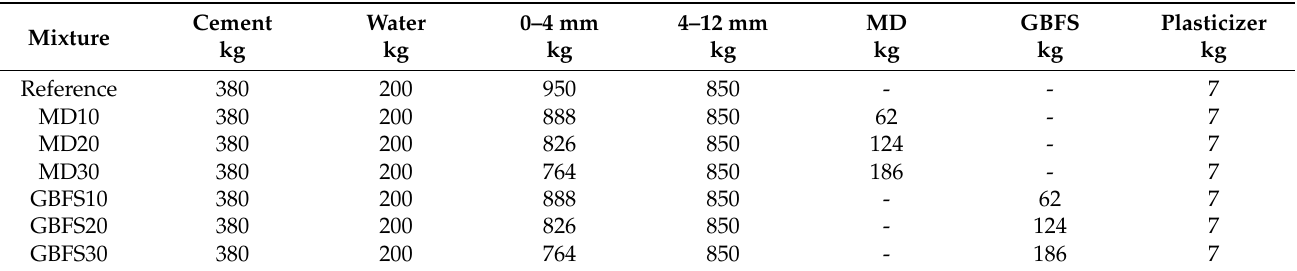
Table 1. Mix proportion of the SCC mixtures for 1 m 3